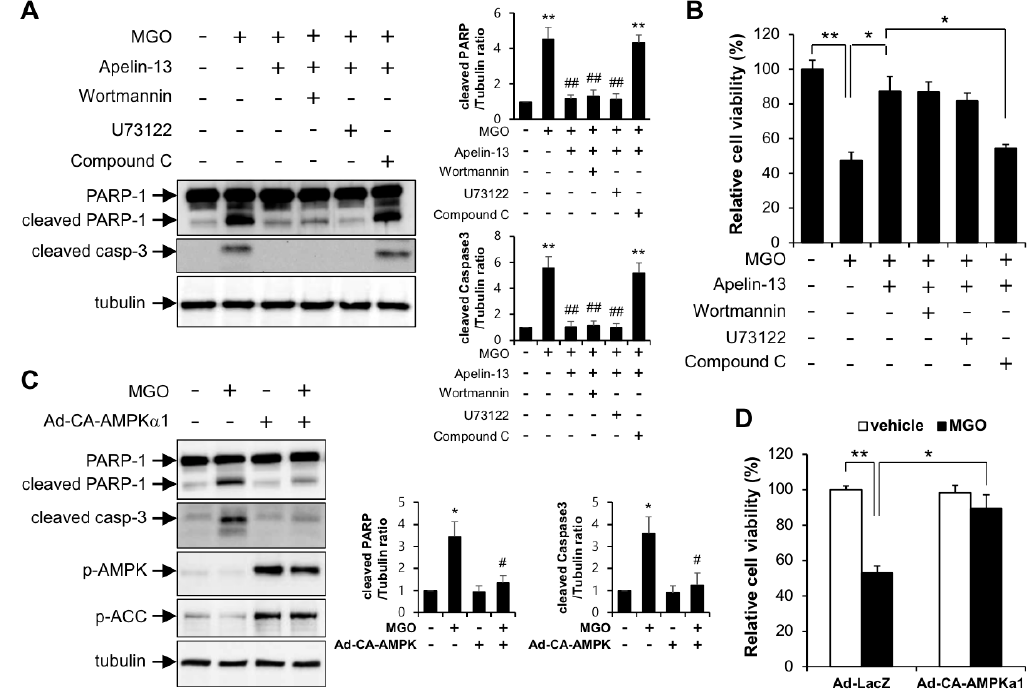
Figure 5. Apelin-13 ameliorates MGO-induced apoptosis through AMPK pathway in HUVECs. Cells pretreated with wortmannin (50 nM), U73122 (1 µ M), and compound C (1 µ M) were stimulated with 100 µ M MGO for 24 h in the presence or absence of 1 µ M apelin-13. ( A ) HUVECs were lysed and then applied for Western blotting analysis. Protein level amounts were determined by immunoblotting with anti-PARP-1 and anti-caspase-3 antibodies. The graph shows the densitometric quantification of Western blot bands. ** p < 0.01 vs. vehicle control, ## p < 0.01 vs. MGO-treated cells ( n = 3). Results are representative of three independent experiments. ( B ) MTT assay was performed as described in the Materials and Methods section. Results are expressed as means ± SDs and are representative of three independent experiments. * p < 0.05, ** p < 0.01 ( n = 3). ( C , D ) To examine the protective role of AMPK in MGO-induced apoptosis, HUVECs infected with Ad-LacZ or Ad-CA-AMPK α 1 were exposed to 100 µ M MGO for 24 h. ( C ) Cells were applied for Western blotting analysis. The graph shows the densitometric quantification of Western blot bands. * p < 0.05 vs. vehicle control, # p < 0.05 vs. MGO-treated cells ( n = 3). Results are representative of three independent experiments. ( D ) MTT assay was performed as described in the Materials and Methods section. Results are expressed as means ± SDs and are representative of three independent experiments. * p < 0.05, ** p < 0.01 ( n = 3).